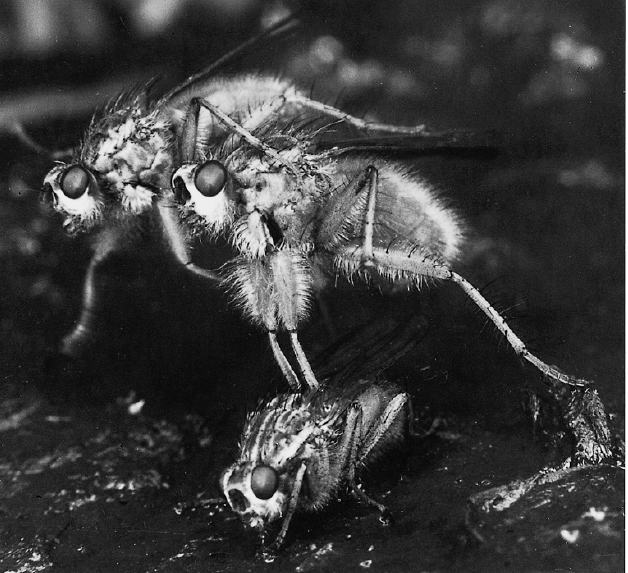
Figure 1. A male dung fly guarding the female he has just mated with against an attacker while she lays her eggs in the cattle dropping. Photograph is from my Ph.D. thesis in 1968, published in 1970